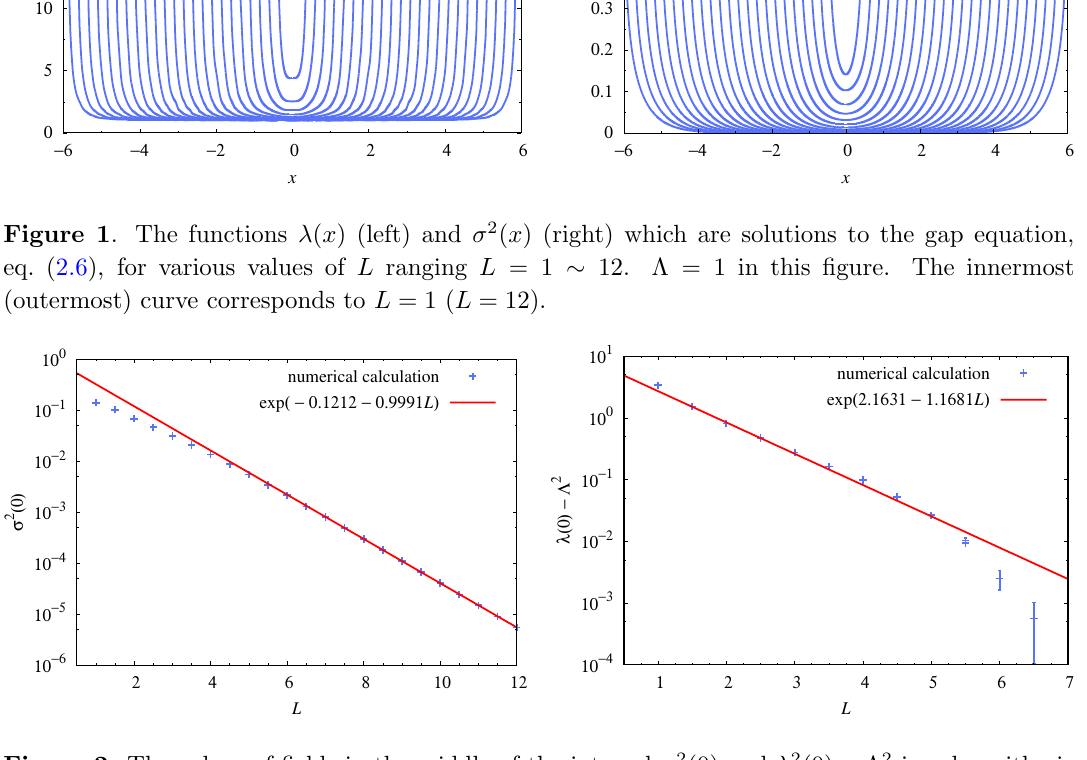
Figure 2 . The values of (cid:12)elds in the middle of the interval (cid:27) 2 (0) and (cid:21) 2 (0) (cid:0) (cid:3) 2 in a logarithmic plot. (cid:3) = 1 in this (cid:12)gure. These (cid:12)gures are just an illustration of the exponential behavior of (cid:27) 2 (0) and (cid:21) 2 (0) (cid:0) (cid:3) 2 as functions of L , and are not intended to be precise (cid:12)ts to theory. Especially the numerical errors are quite large at large L in the right (cid:12)gure (but still much smaller than (cid:3) 2 =